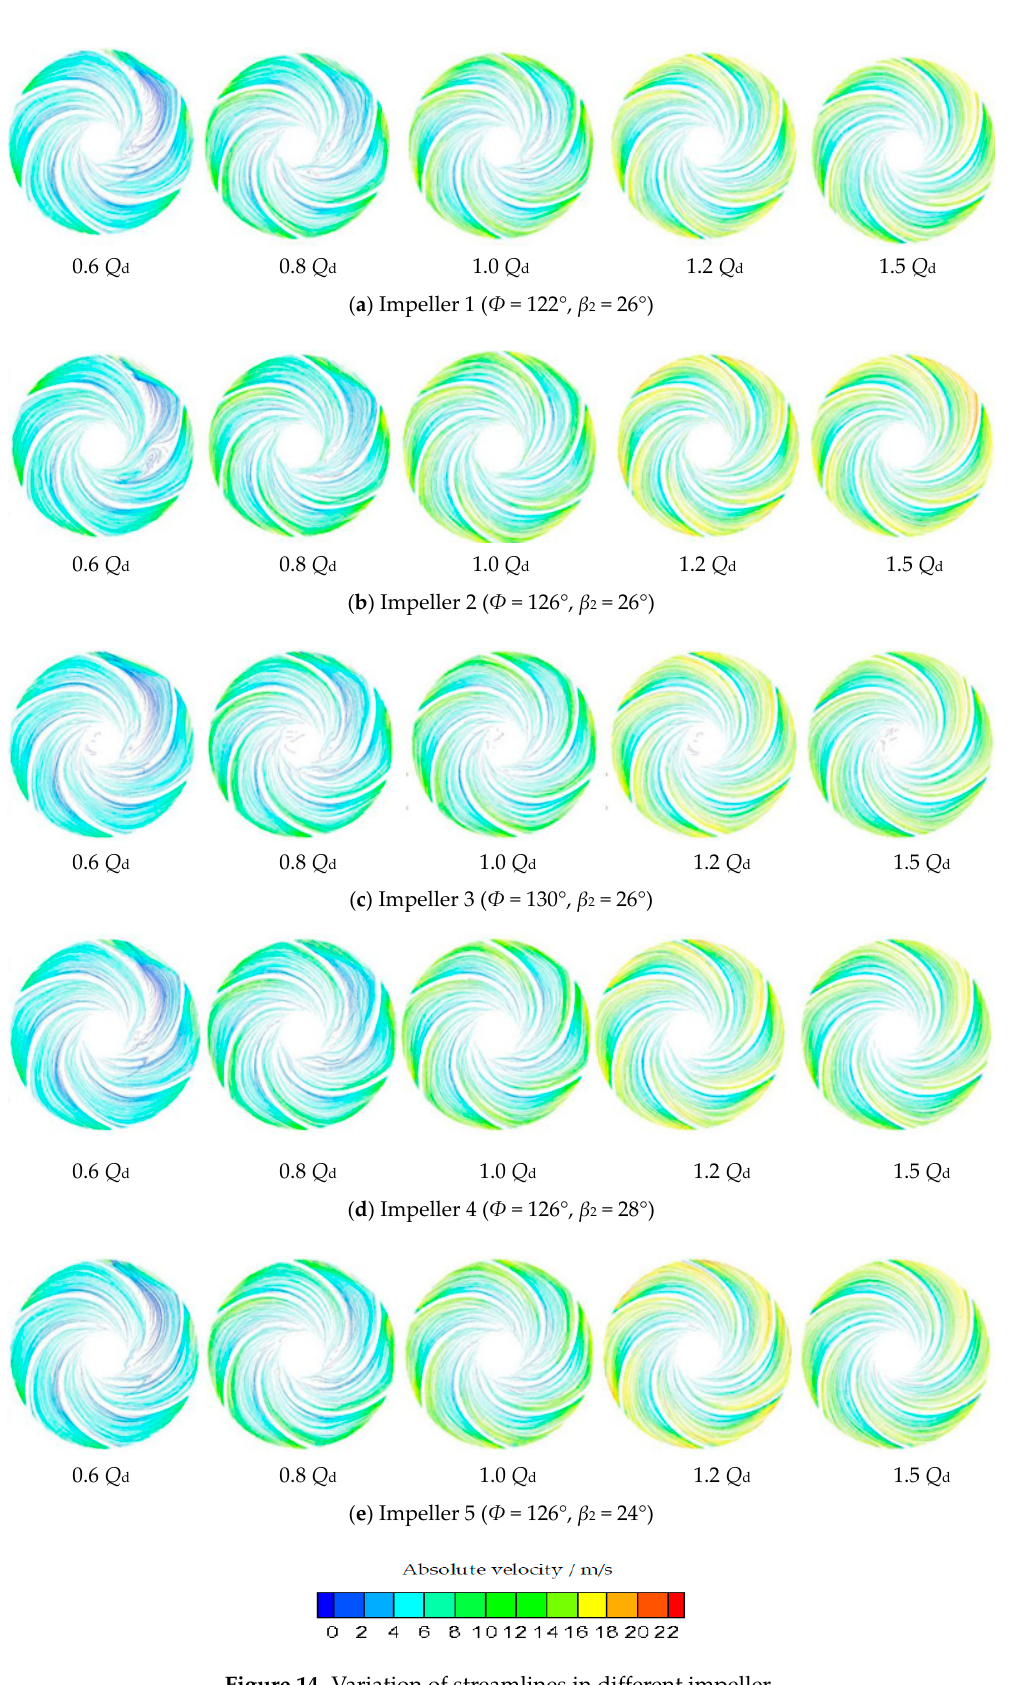
Figure 14. Variation of streamlines in different impeller.